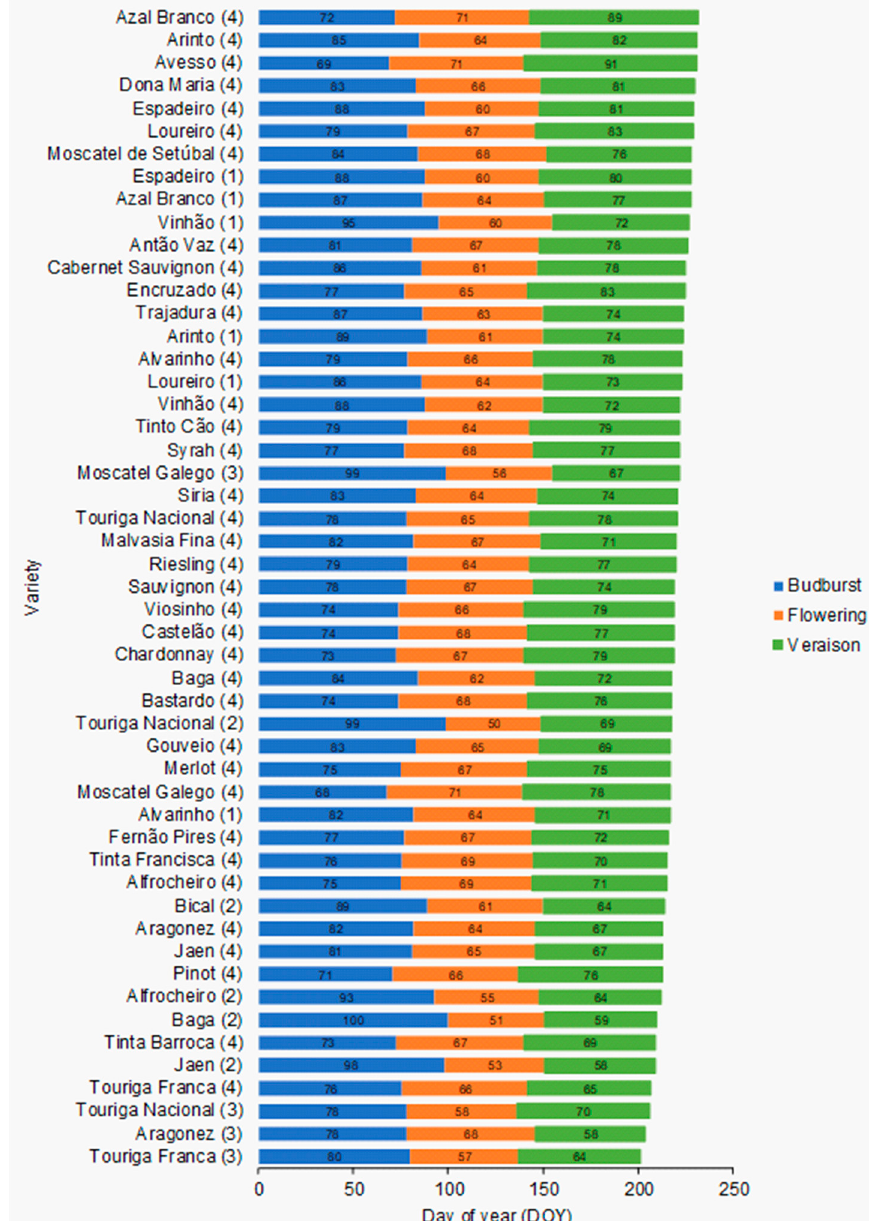
Figure 2. Average day of the year (DOY) observed for each variety, phenological stage (budburst, flowering, and veraison, cf. legend) and wine region: Vinhos Verdes (1), Dão (2), Douro (3), and Lisboa (4). The average values are ranked according to the veraison date. The values outlined in the bars correspond to the mean duration of each phenophase (1 January–budburst; budburst–flowering;